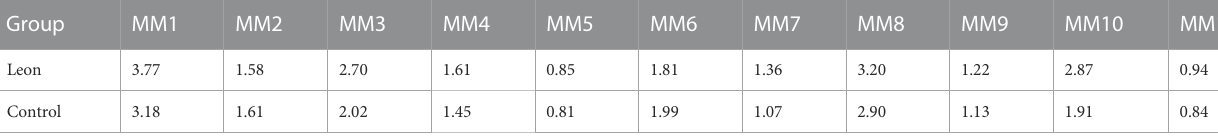
TABLE 7 The MFI of CD40 expression on moDCs (× 10 5 ) (MM patient-moDCs, n = 11).